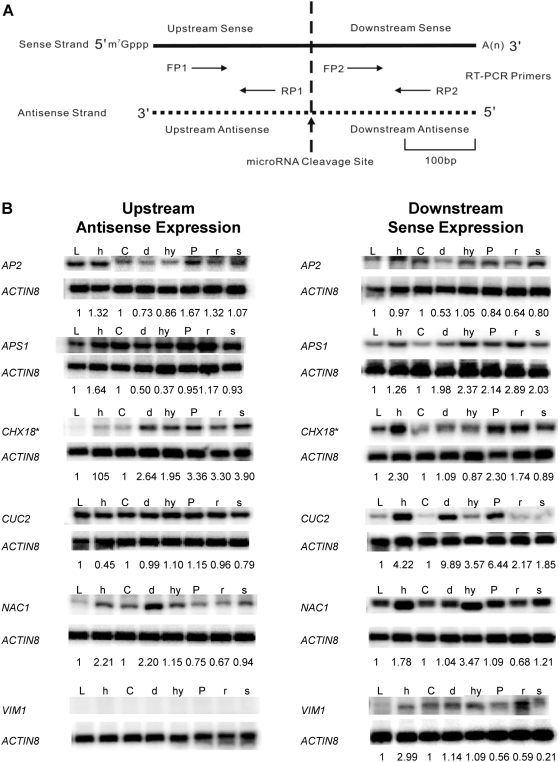
qRT-PCR for sense and antisense expression of selected miRNA targets.(A) Cartoon showing experimental design. For each selected miRNA target, two pairs of primers are designed, one pair located upstream of the miRNA cleavage site (dashed vertical line) labeled as FP1 and RP1 (forward primer1 and reverse primer1), and another pair located downstream of the miRNA cleavage site labeled as FP2 and RP2 (forward primer2 and reverse primer2). Regions queried (upstream or downstream) are defined according to their positions relative to the miRNA cleavage site. Approximate scale of average-sized PCR products (∼100 b.p.) is indicated. (B) qRT-PCR results for validated miRNA targets AP2/AT4G36920, APS1/AT3G22890, CHX18/AT5G41610, CUC2/AT5G53950, NAC1/AT1G56010 and a paralogous non-target VIM1/At1g57820. On the right panel “Downstream Sense Expression”, the primer RP2 was used in the reverse transcription and primers FP2+RP2 were used in the following PCR reaction. On the left panel “Upstream antisense expression”, the primer FP1 was used in the reverse transcription and primers FP1+RP1 were used in the following PCR reaction. ACTIN8 primer pairs for sense strand expression were included in each qRT-PCR reaction as a duplexed semi-quantitative internal control. The relative expression value of each qRT-PCR band normalized to its ACTIN8 signal is indicated below each lane. No band was detected when reverse transcriptase was omitted from the reverse transcription reaction in negative controls (data not shown). L: wild type Ler-0; h: hen1-1; C: wild type Col-0; d: dcl1-7; hy: hyl1-2; P: a P1/HC-Pro over-expressing line; r: rdr6-15; s: sgs3-14. Each panel is a representation of at least three independent replicates from each of two biological samples that gave similar results. Asterisk (*) in the panel for CHX18 denotes the region upstream or downstream of the miR856 cleavage site on CHX18 mRNA.